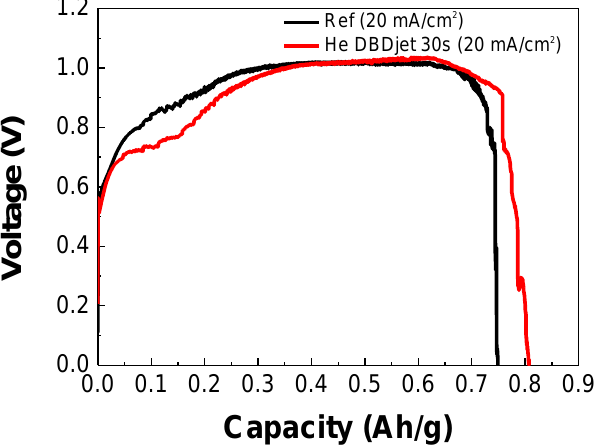
Figure 8. Discharge curves at a current density of 20 mA/cm 2 .